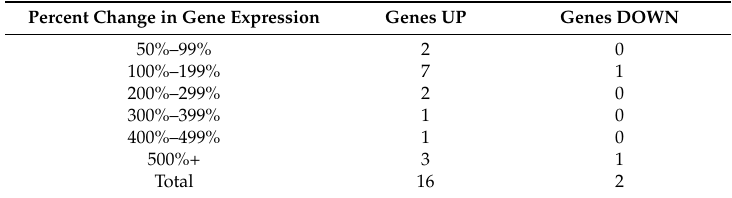
Table 5. Distribution of Genes Affected by GHK with Antioxidant Activity.